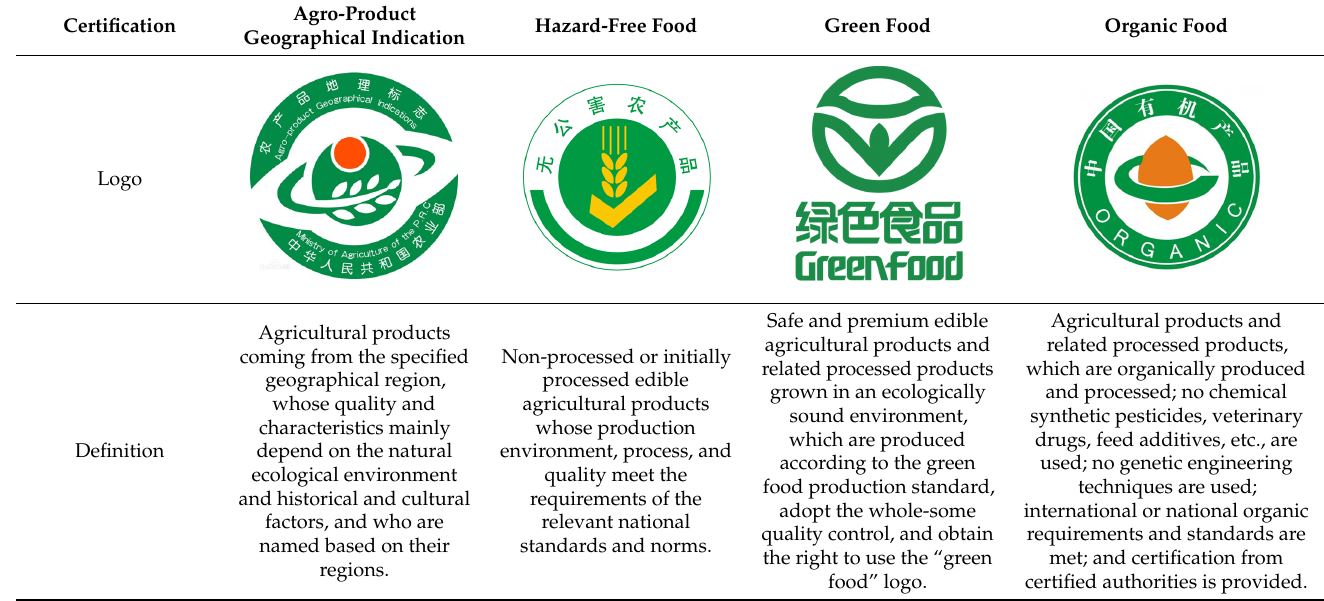
Table 1. Comparison of agro-product geographical indications, hazard-free food, green food, and organic food certifications. Certification